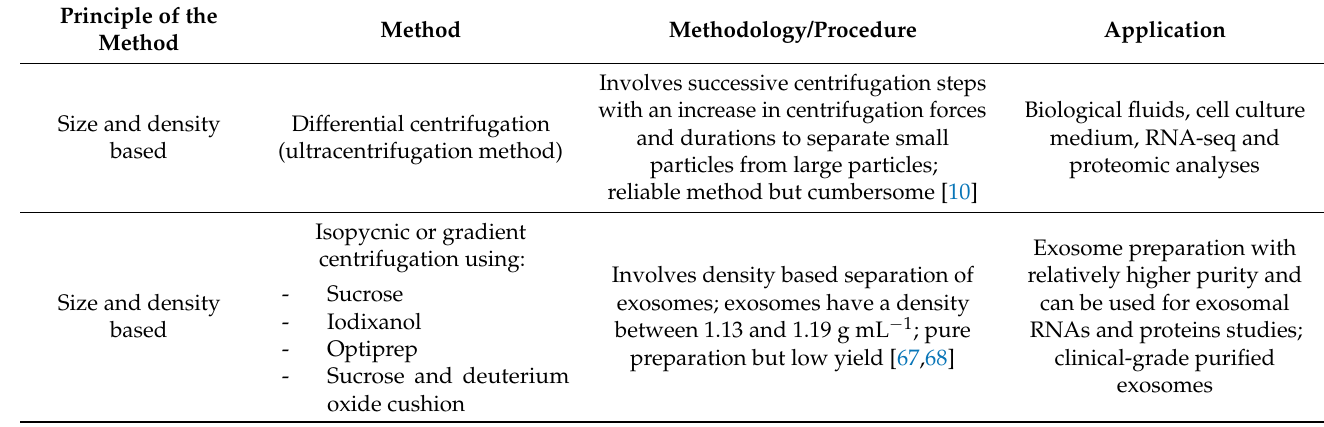
Table 1. Various methods developed and employed for exosome